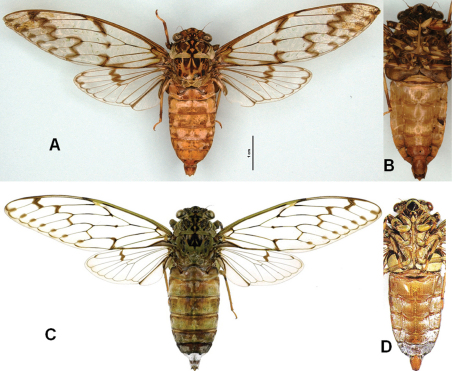
Semia species in dorsal view and ventral view (male): A, BSemia klapperichi(photograph by Dirk Ahrens) C, D
Semia wantanabei (after Chen 2007).